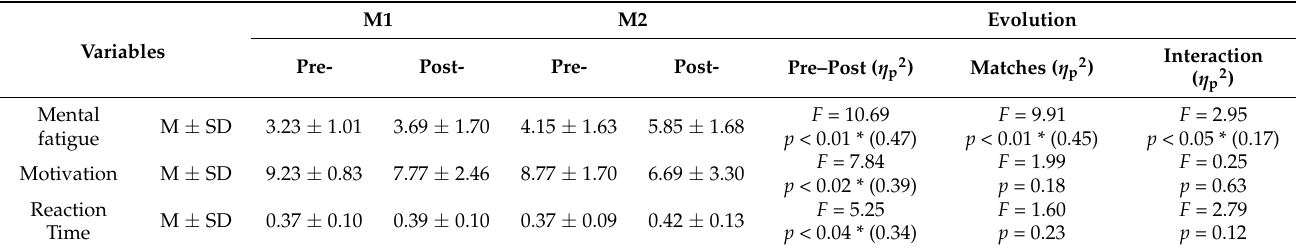
Table 1. Mental fatigue, motivation and reaction time from pre- to post-two matches evolution ( n = 14). M1 Variables